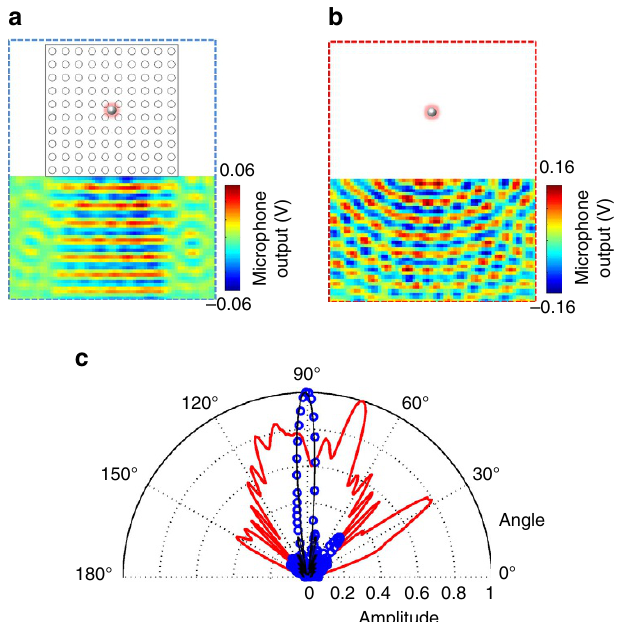
Figure 3 | Acoustic plane wave generation from a point source in the zero refractive index metamaterial. ( a ) Measured pressure field radiated by acoustic point source embedded in zero refractive index metamaterial. The zero refractive index metamaterial collimates the emission from a point source to a plane wave. ( b ) Measured pressure field radiated by an acoustic point source in the empty waveguide. Without zero refractive index material, a cylindrical wave pattern is obtained in the waveguide. ( c ) Directivity of a collimated plane wave. The blue circles and red curve are directivities corresponding to the pressure field radiations shown in a , b , respectively. The black curve is the calculated directivity of an ideal line source with the same size (10 unit cells, that is, 6.5 wavelengths). The zero index metamaterial collimates the acoustic pressure field within 11 ± 1 (cid:2) , close to 10.6 (cid:2) given by the theoretical limit of the line source. The noise observed on both experimental results is due to the spurious reflection from the waveguide edges.